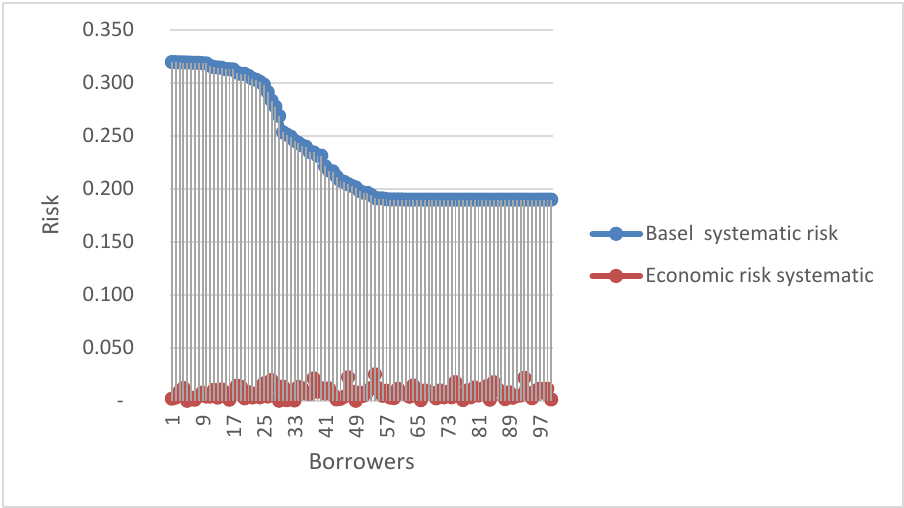
Figure 2. Economic and Basel systematic risk.